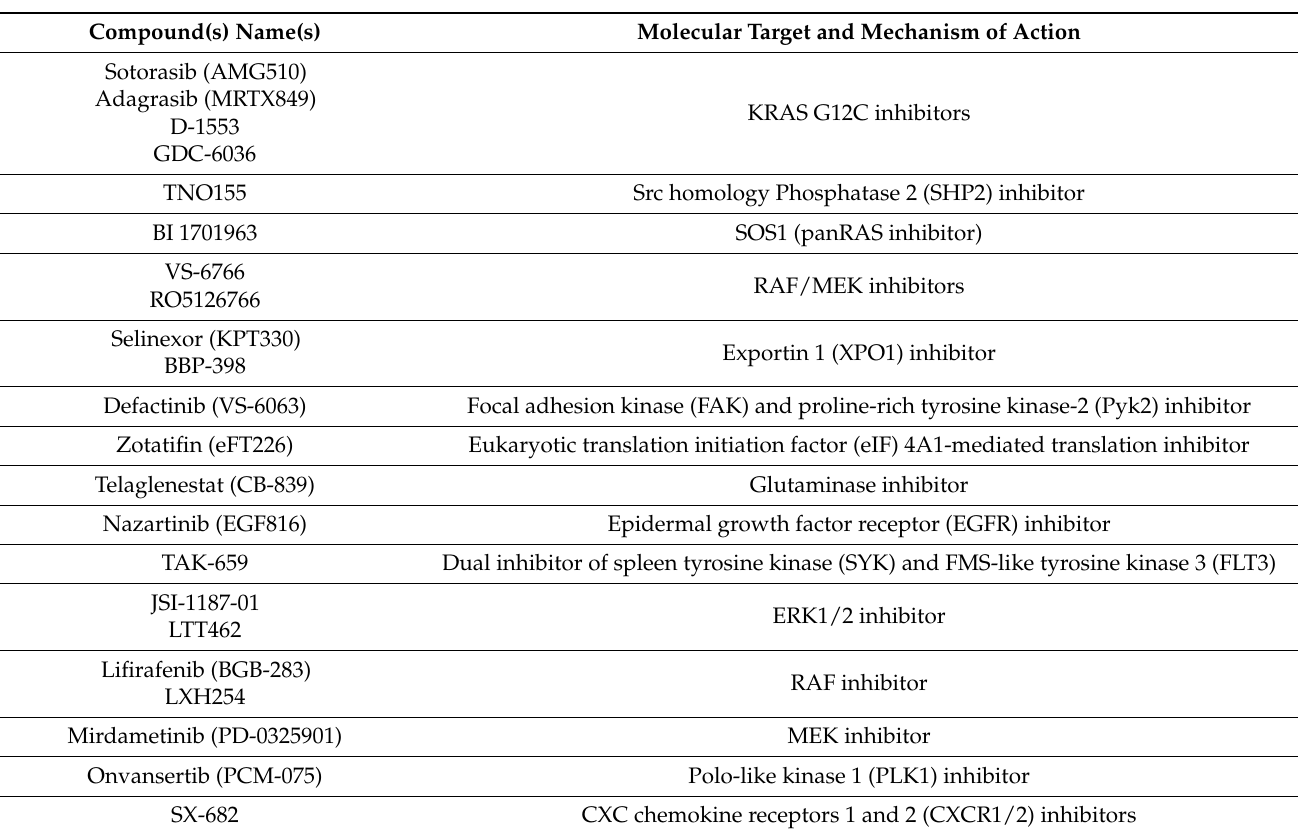
Table 3. Overview of novel therapeutic compounds acting on KRAS signaling pathways under investigation in KRAS mutated tumors. Compound(s)